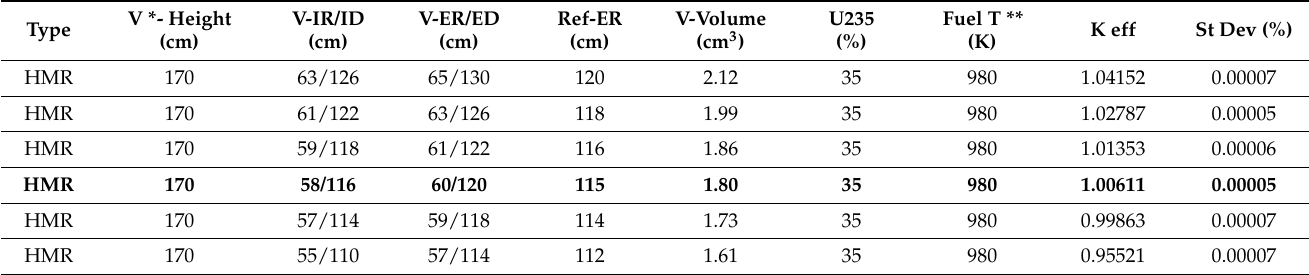
Table 7. Criticality search results for iMAGINE-HMR salt fuel